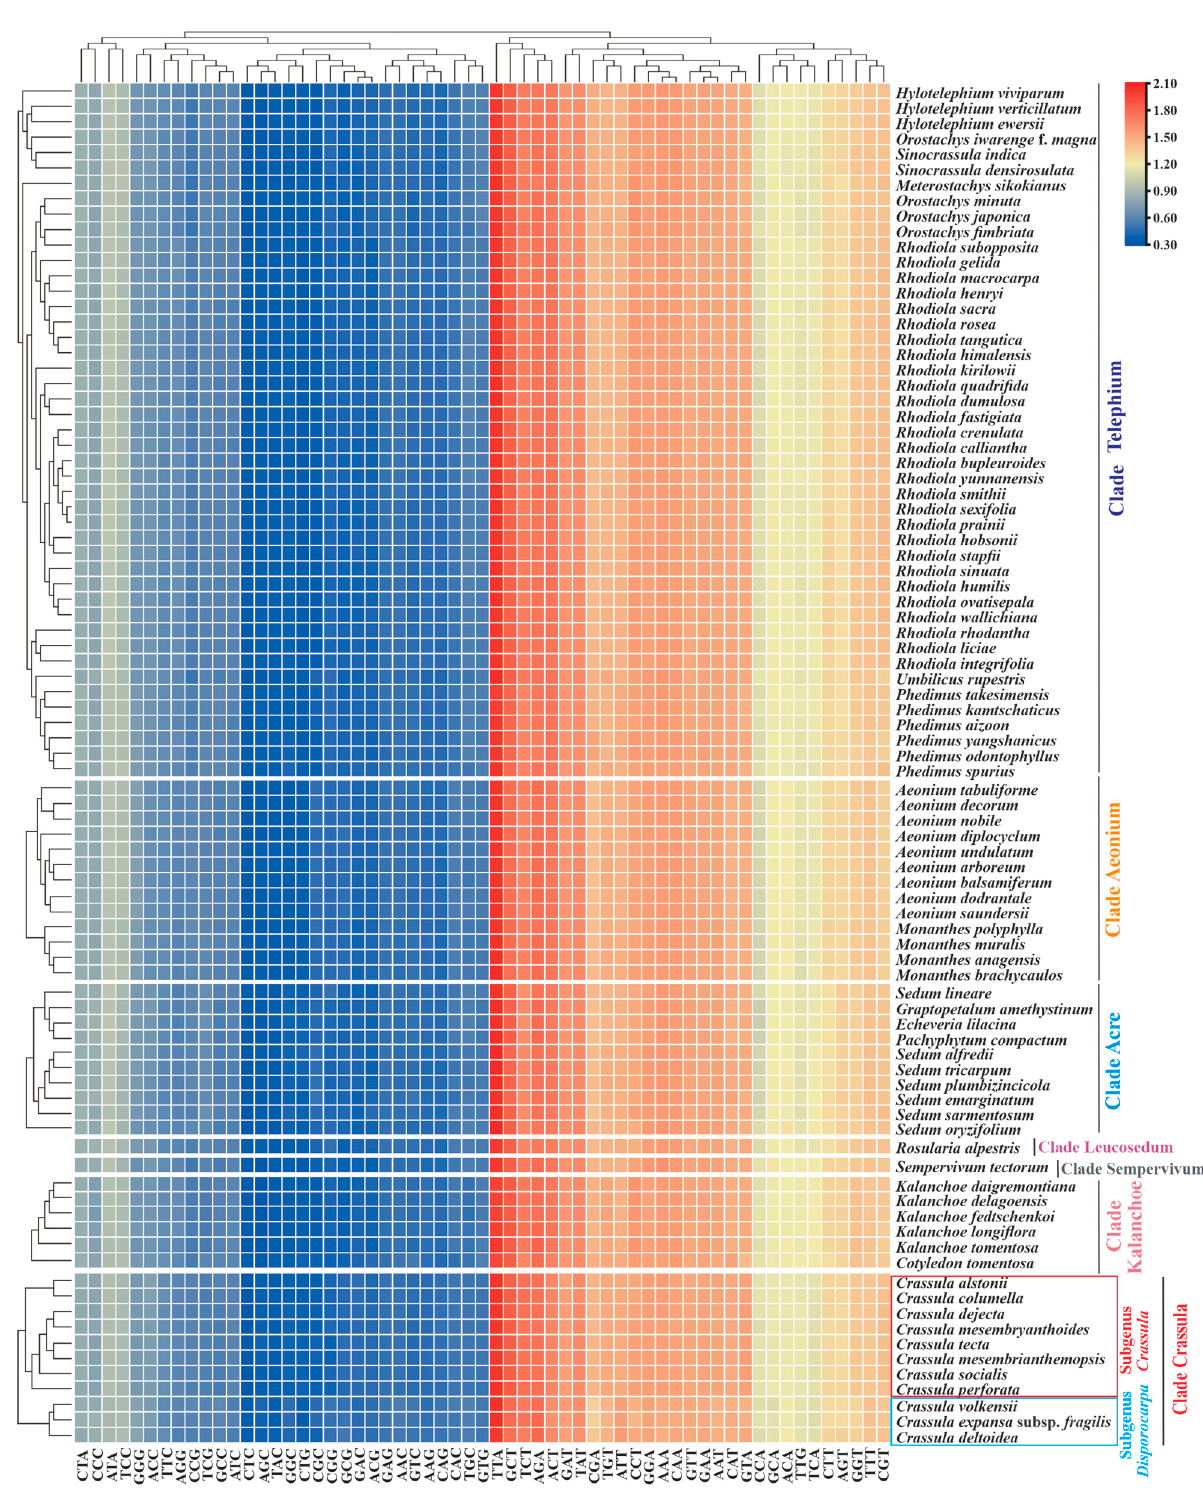
Figure 5. The heatmap of overall RSCU values among 7 clades of Crassulaceae species based on 53 concatenated plastid genes (length ≥ 300 bp). The x-axis: the cluster of different codons; y-axis: the clusters of species.